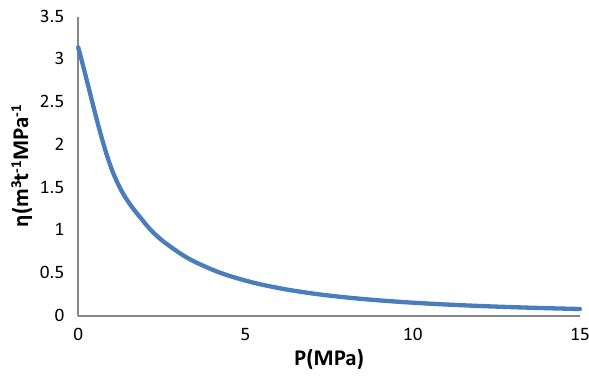
Fig. 1 Desorption efficiency curve of Y88-1 sample